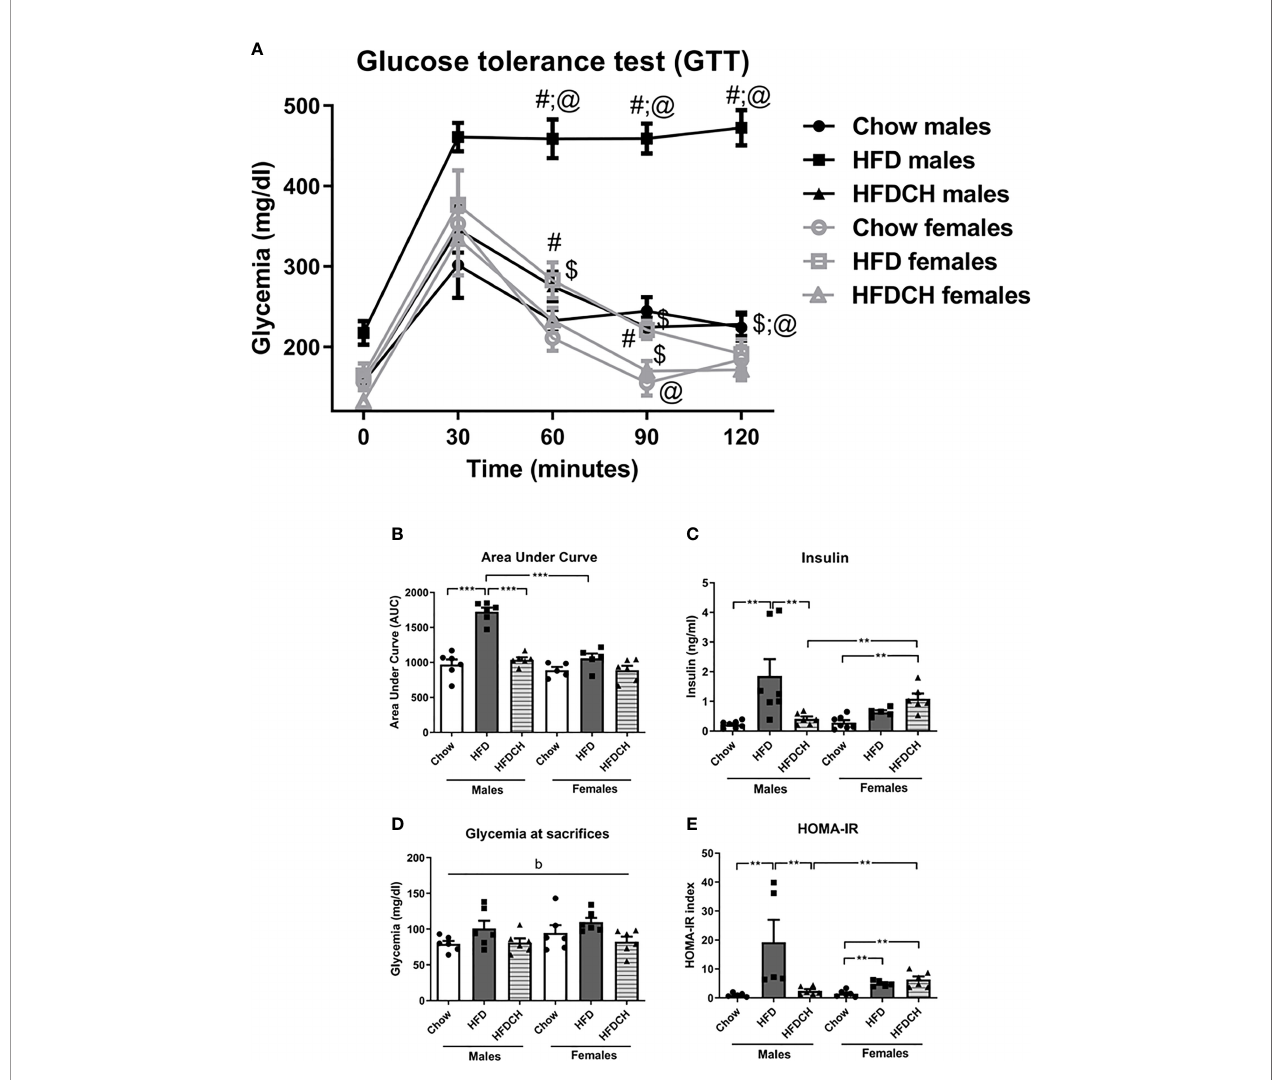
FIGURE 3 | Glucose tolerance test (A) , the area under curve (AUC) of the GTT (B) , circulating insulin levels (C) and glycemia at sacri fi ce (D) , and Homeostatic Model Assessment for Insulin Resistance (HOMA-IR; E ) in male and female mice exposed to chow or a high-fat diet (HFD) for 12 weeks, or HFD for 8 weeks and then switched to chow during the last 4 weeks (HFDCH) of the study. **p < 0.01, *** p< 0.001; #, different from chow, $, different from HFD, @, differences between sexes on the same diet. b: effect of the diet. n =